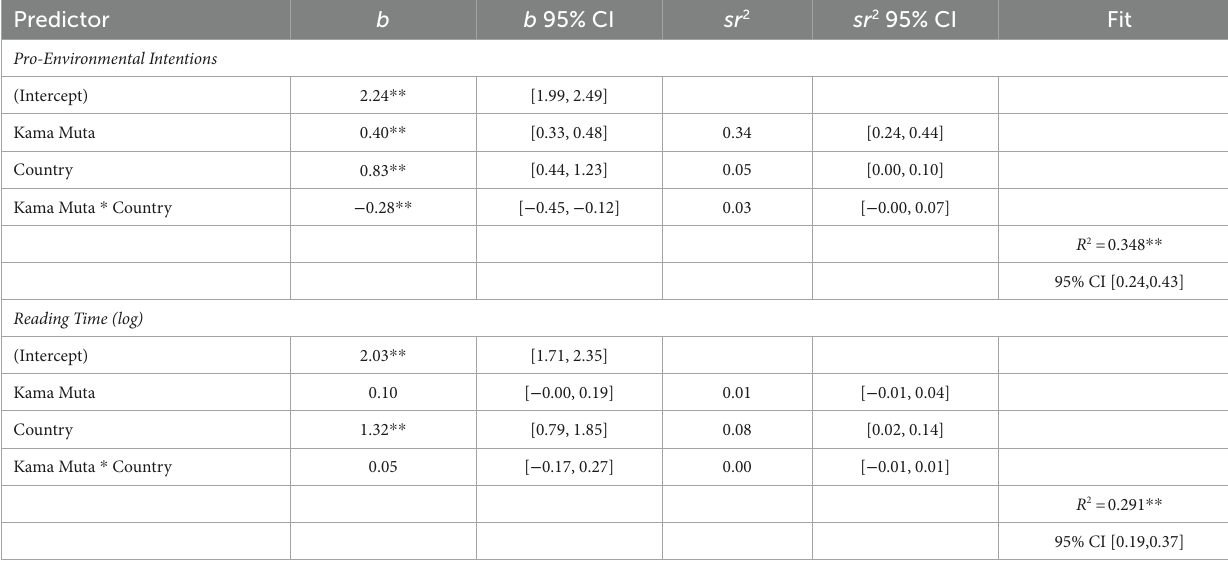
TABLE 2 Regression results using intention and reading time as the criterion in Study 1.